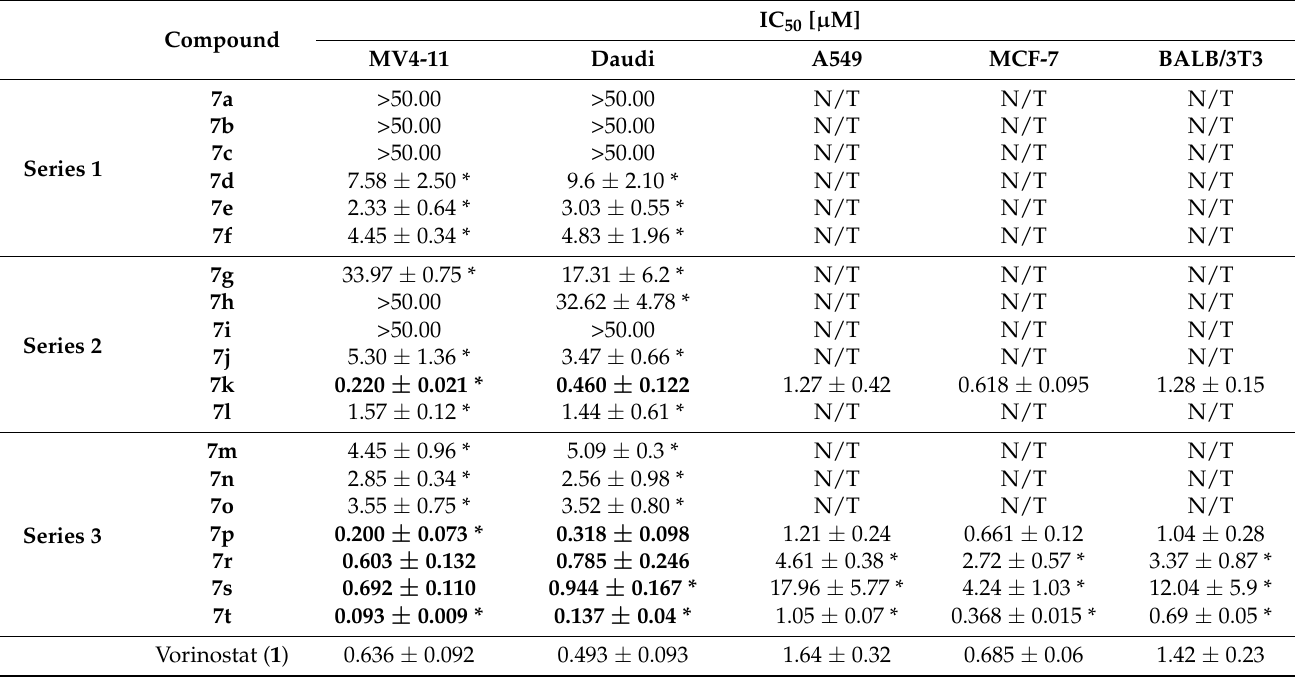
Table 3. IC 50 [ µ M] of Vorinostat derivatives 7a-t based on the survival of non-cancerous (BALB/3T3) and cancerous (MV4-11, Daudi, MCF-7 and A549) cells after 72 h of treatment. N/T—not tested. Compound